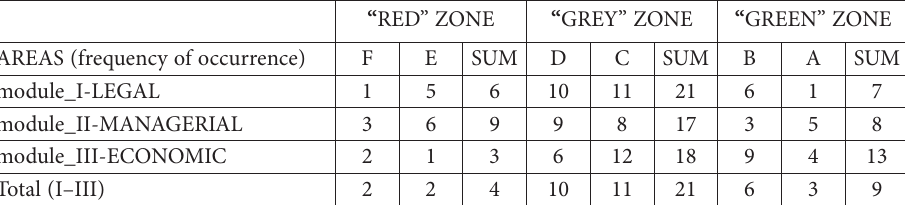
Table 3. Number of companies within each business vitality rating grade “ RED” ZONE “ GREY” ZONE “ GREEN” ZONE AREAS (frequency of